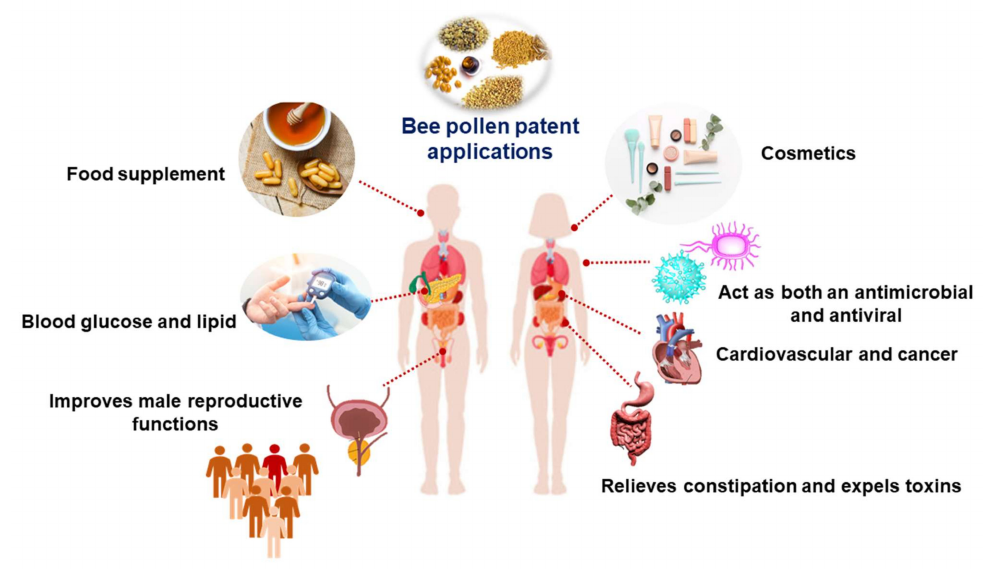
Figure 2. Bee pollen patent